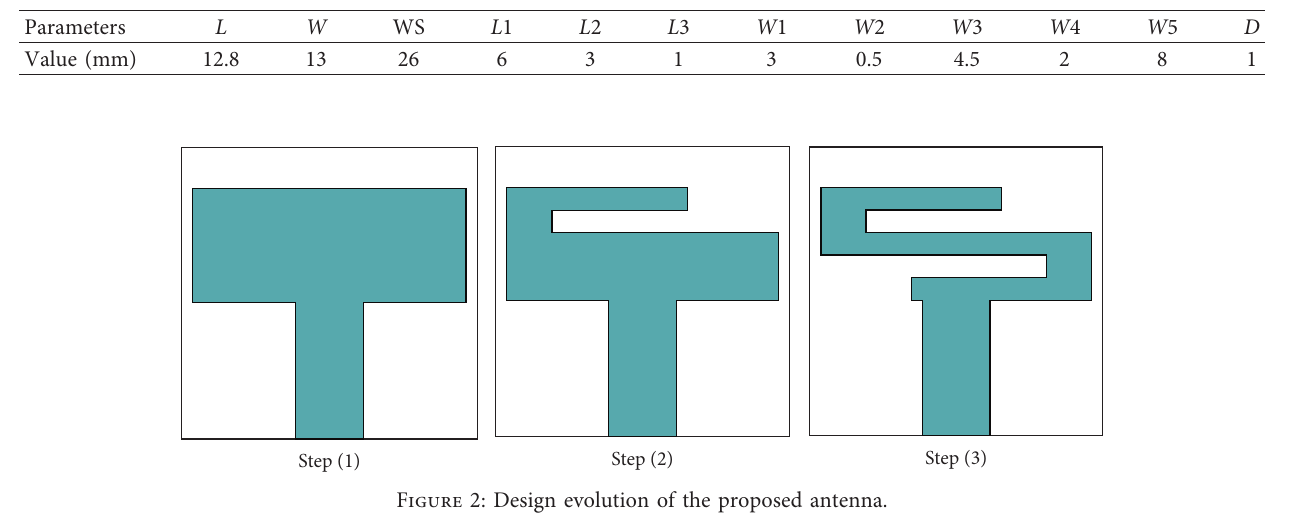
Table 1: Dimensions of the proposed antenna